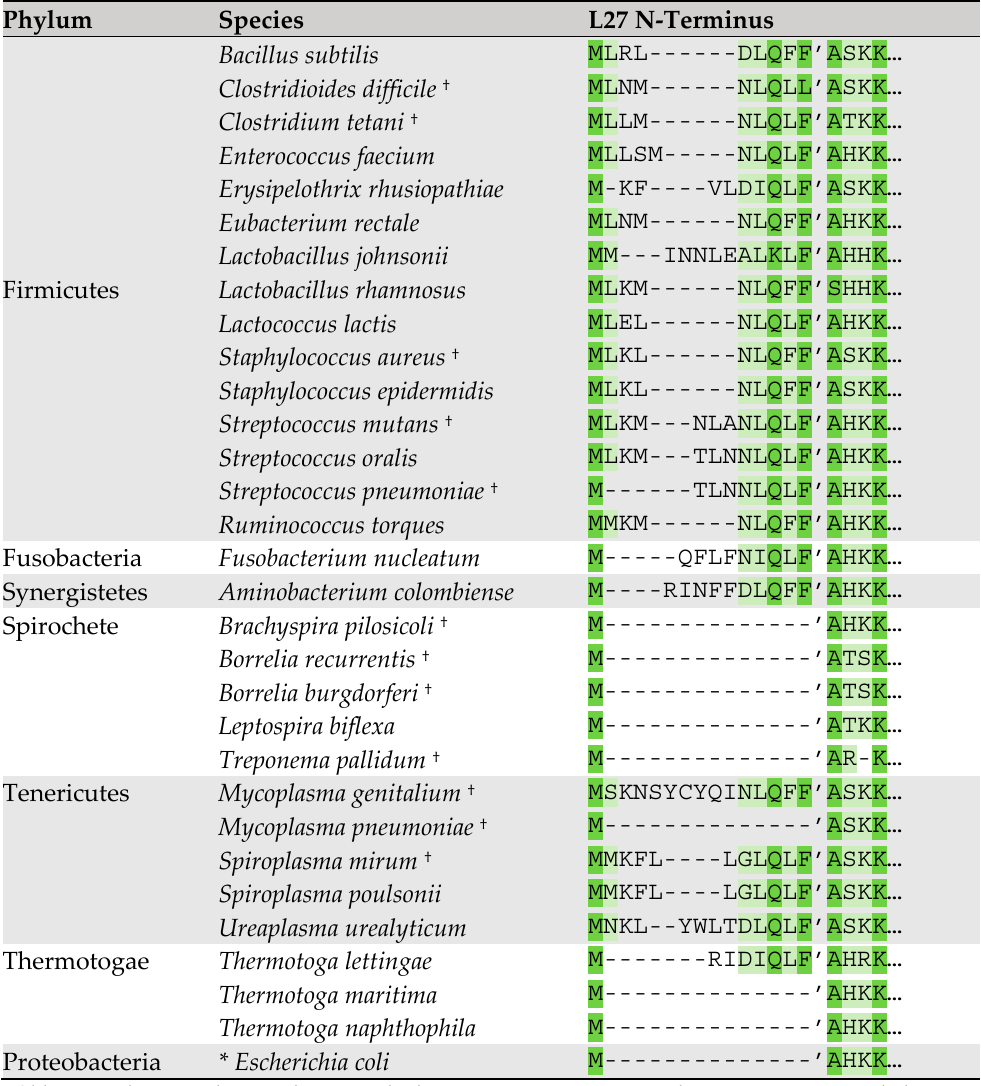
Table 2. L27 N-terminal extension cleavage sequence